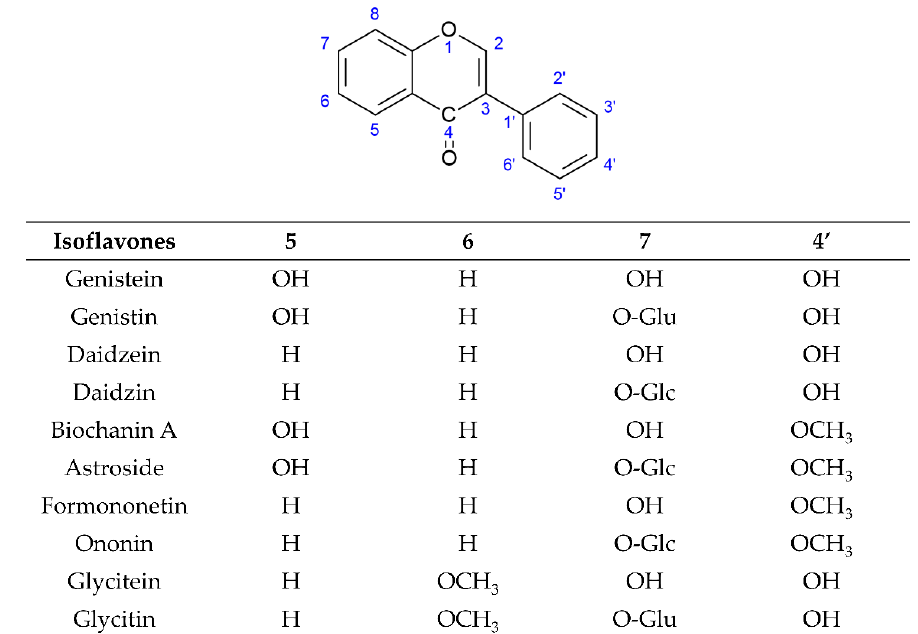
Figure 2. Structures of novel simple O-substituted